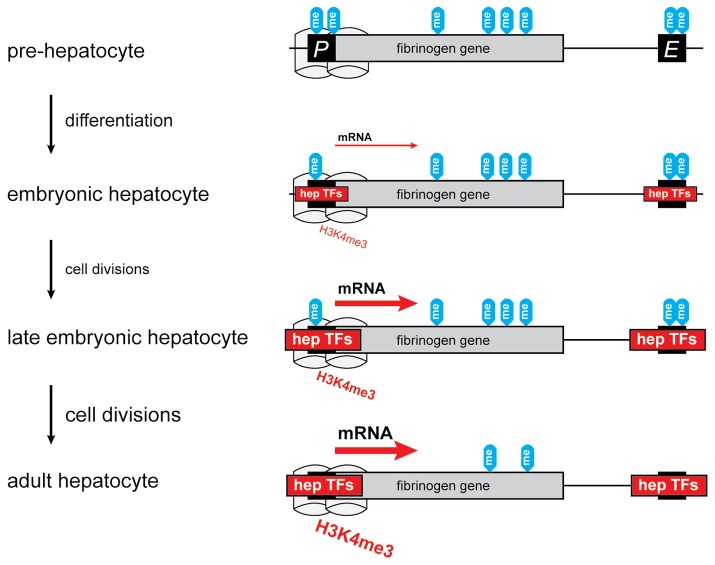
A model of changes in epigenetic marks and expression of fibrinogen genes during development.A single fibrinogen gene is shown here to represent the three vertebrate fibrinogen chain genes and the model represents an average situation in a population of cells. An upstream promoter (P) and an intergenic liver enhancer (E) sequence are also represented. Prior to hepatocyte differentiation, CpGs in the fibrinogen genes are methylated (“me”) both in regulatory sequences and across the gene bodies. Embryonic hepatocytes show similar CpG methylation patterns, but with the expression of hepatocyte transcription factors (hep TFs) regulatory sequences are employed and fibrinogen mRNA expression is measurable. The H3K4me3 histone mark is also detectable near the gene promoters (grey cylinders). In later embryonic hepatocytes, expression of fibrinogen is clearly increased (red arrow), the H3K4me3 mark is more abundant at promoters and CpG methylation is moderately reduced, perhaps as a result of the loss of repressive CpG methylation upon cell division. In adult hepatocytes expression is marginally higher still, but CpG methylation is markedly reduced, in gene bodies and regulatory elements.